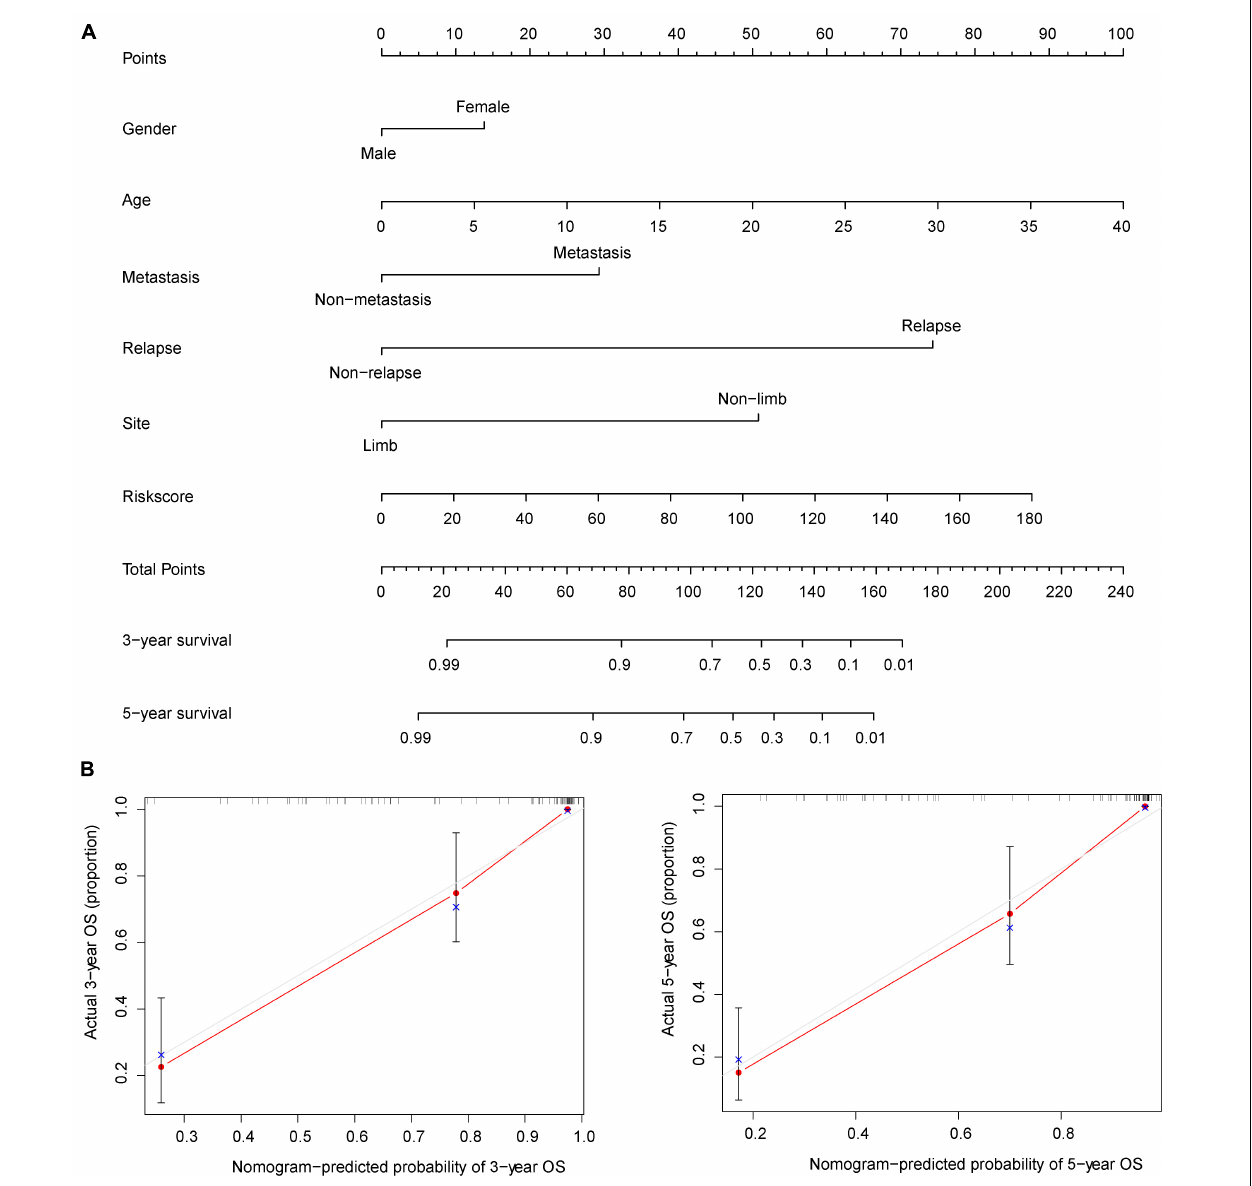
FIGURE 4 | Nomogram for evaluating the prognosis of osteosarcoma at 3 and 5 years. (A) The risk score and clinical characteristics of osteosarcoma were used to construct the nomogram. (B) Calibration curves were used to verify the accuracy of the nomogram.